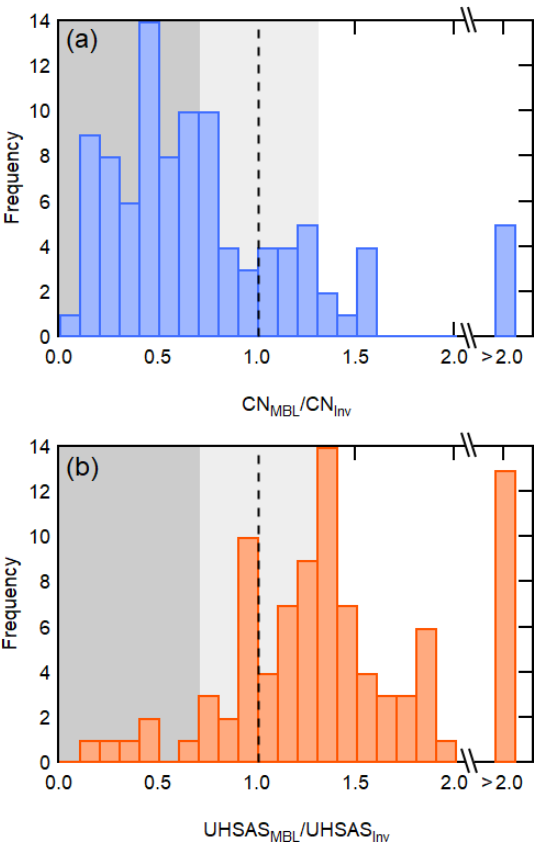
Figure 10. Histogram of (a) CN MBL / CN Inv from Fig. 7 and (b) UHSAS MBL / UHSAS Inv from Fig.